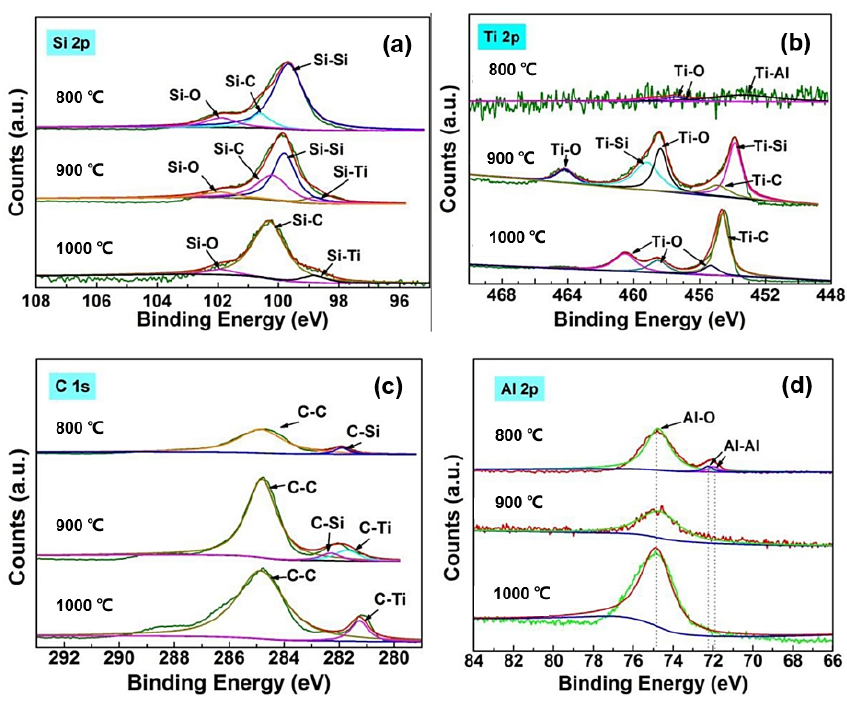
Figure 6. XPS spectra of the Si 2p ( a ), Ti 2p ( b ), C 1s ( c ), and Al 2p ( d ) lines of SiC ceramics infiltrated at 800, 900, and 1000 °C for 6 h.